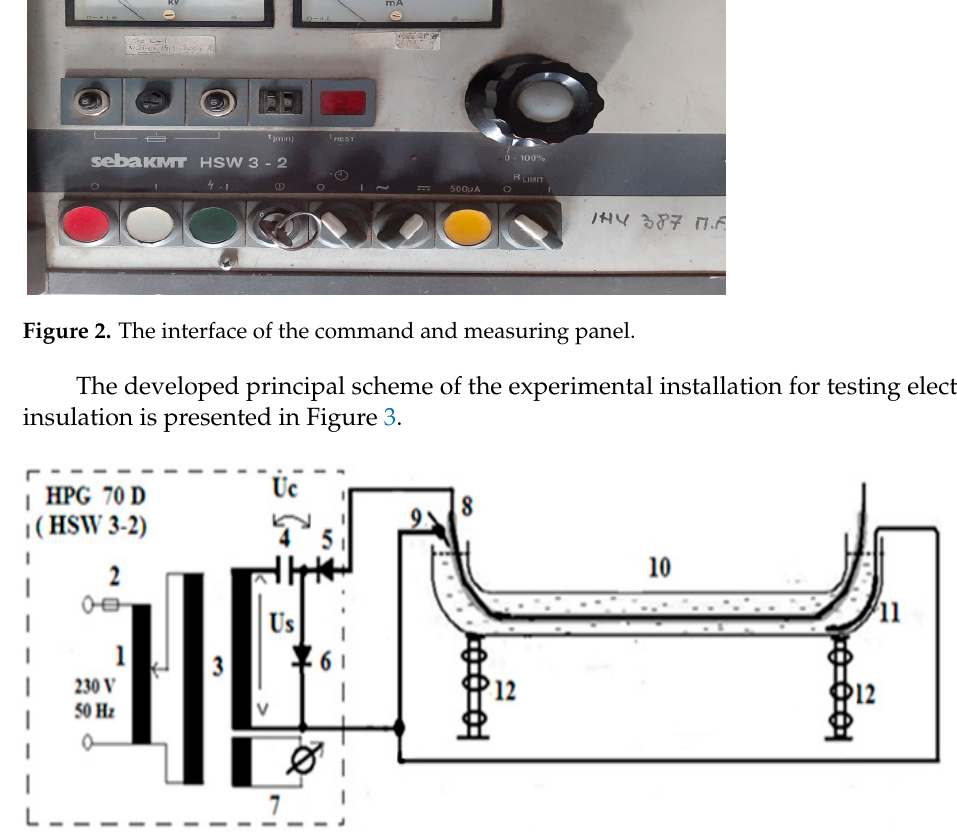
Figure 3. Components of the experimental installation for testing with high voltage using DC cur ‐